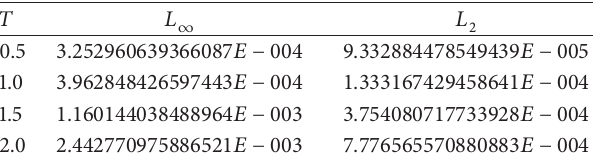
Table 6: Error norms at different time stages for equation 𝑢 𝑡 +𝑢 2 𝑢 𝑥 + = 0 , with initial condition (38) for 𝑛 = 2 , 𝑑𝑥 = 0.01 , and 𝜀𝑢 𝑥𝑥𝑥 𝑑𝑡 = 0.5 × 𝑑𝑥 2 . 𝑇 𝐿